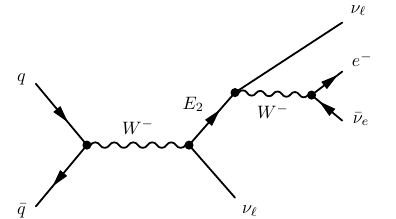
Figure 4. Leading-order Feynman diagrams for the VLBSM topologies. The same nomenclature as in figure 2 applies